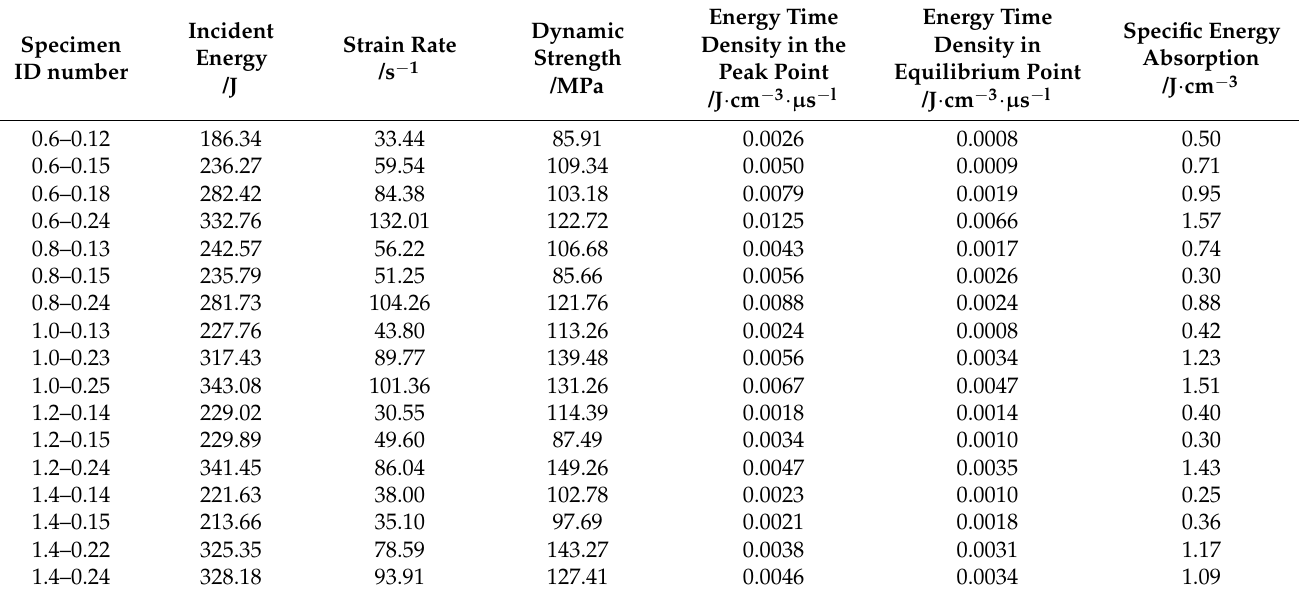
The equilibrium point and peak point curves show the sensitivity of w td to strain